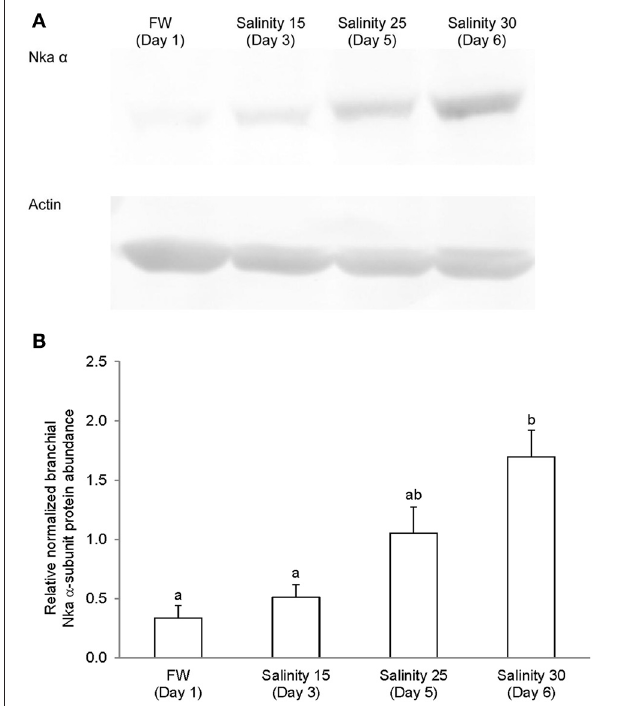
FIGURE 10 | Protein abundance of Na + /K + -ATPase (Nka) α -subunit in the gills of Anabas testudineus kept in freshwater on day 1 (FW; control), or after 24h of exposure to salinity 15 on day 3, salinity 25 on day 5, or salinity 30 (seawater) on day 6 during a progressive acclimation from freshwater to seawater. (A) Immunoblotsof Nka α -subunit and actin. (B) The intensity of the Nka α -subunit band normalized with respect to actin. Results represent mean + S.E.M. ( N = 4). Means not sharing the same letter are significantly different ( P < 0 .